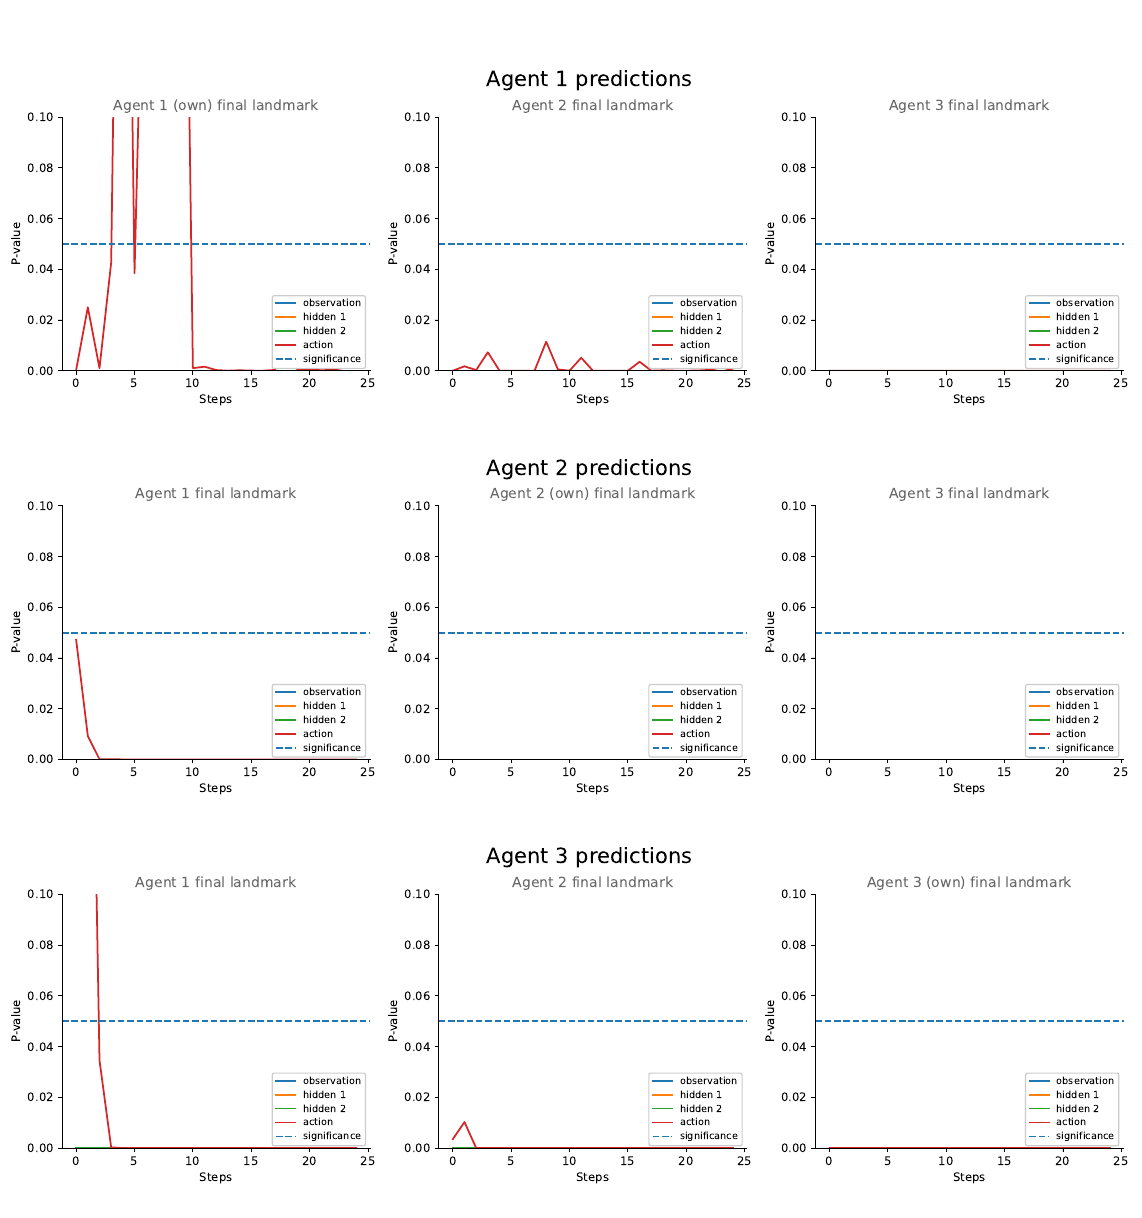
Figure A2. Significance for the accuracies shown in Figure 4. The p -values were calculated using binomial test against chance probability 33%. This shows most of the results have very low p -values, and therefore, were significant, with the exception of predicting from action, which was very close to random chance, as expected. Non-random prediction from observation and action can be explained by some remaining bias in the agents to prefer certain landmark, which can be learned by the linear readout